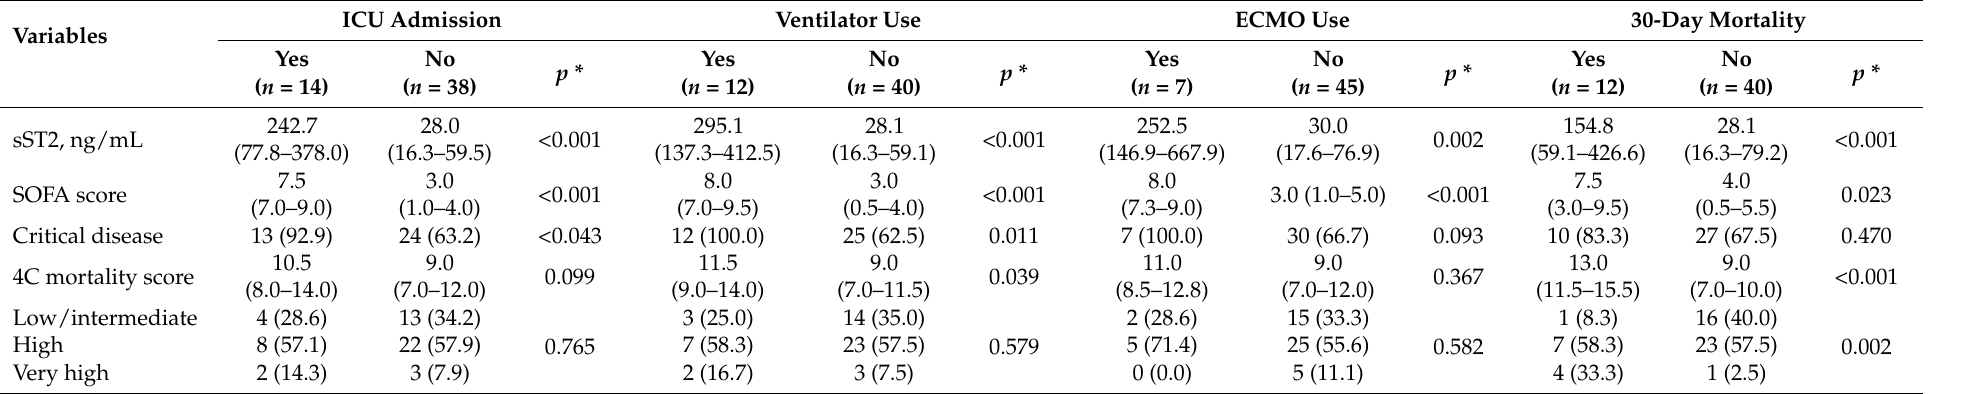
Table 2. sST2, SOFA score, critical disease, and 4C mortality score according to clinical